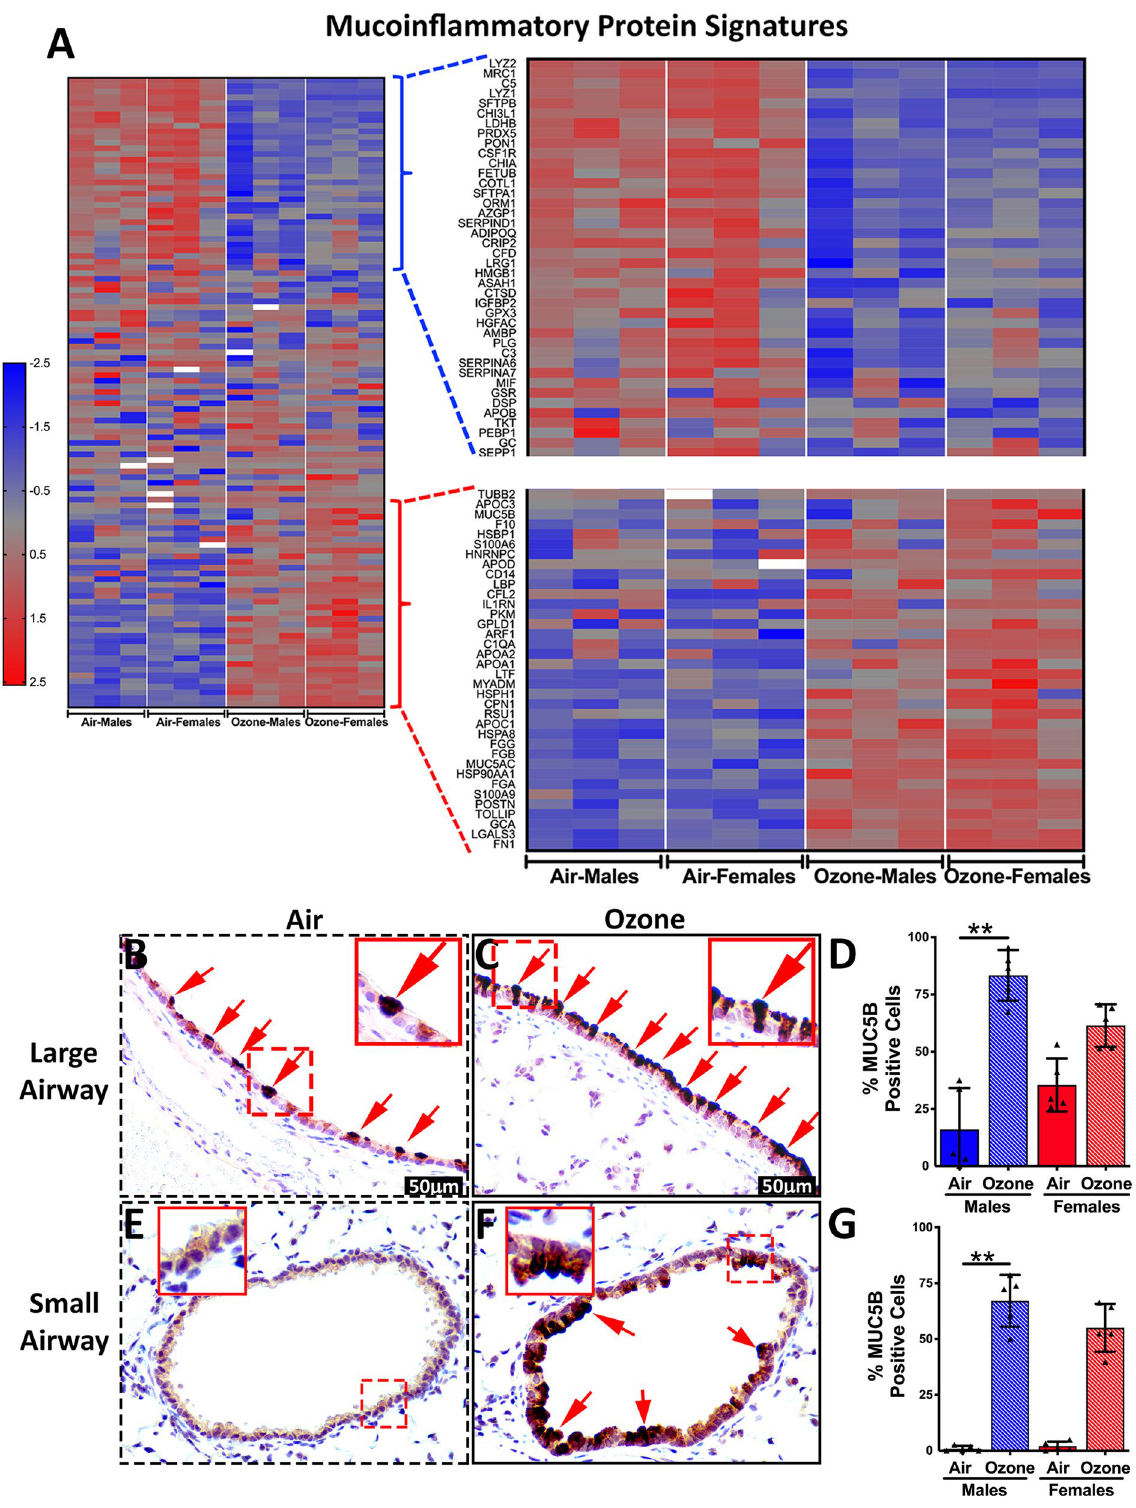
Figure 5. ( A ) Heat maps for normalized values (Z-scores) for proteins associated with mucoinflammatory lung diseases in mice and humans. Low-resolution heat map (Left) depicting expression patterns for the entire muco-inflammatory proteins (High resolution heatmap with protein names is presented as Supplemental Fig. 1). Heat map corresponding to protein signatures that were low abundance (Top) or enriched (Bottom) in exosomes from ozone-exposed mice was amplified for better resolution. ( B – G ) Immunohistochemical analyses of lung sections for expression of MUC5B in large airways ( B and C ) and small airways ( E and F ) from air-exposed ( B and E ) and ozone-exposed ( C and F ) mice. Significant main effect was detected for both large (Kruskal Wallis Statistic = 15.32; df = 3; p = 0.0016) and small (Kruskal Wallis Statistic = 15.17; df = 3; p = 0.0017) airways. Red arrows point to the MUC5B-stained epithelial cells ( B , air-exposed; C and F , ozone-exposed). Bar graph showing the proportion of epithelial cells in the large ( D ) and small ( G ) airways that were stained positive for MUC5B. Error bars represent Standard Deviation (SD). ** p < 0.01 using Kruskal Wallis test followed by Dunn’s post hoc comparisons (n = 5 per